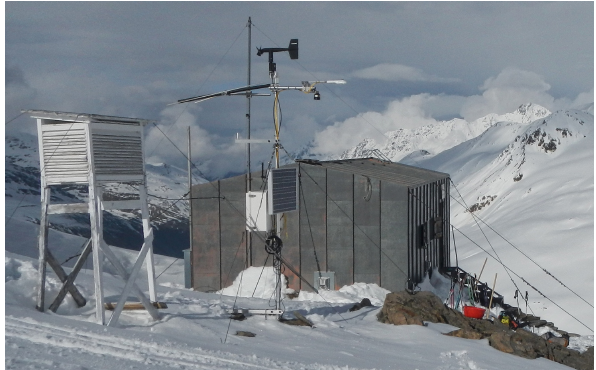
Figure 10. The Hintereisferner AWS and research station in June 2013 (3026ma.s.l., 46.79867 ◦ N, 10.76042 ◦ E), view to the north- east. Photo by Christian Wild.